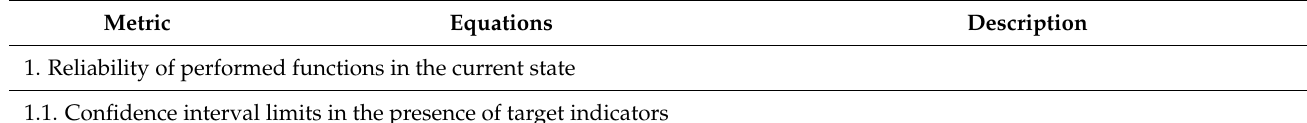
Table 2. A set of metrics for verifying the state of the system’s currently executing